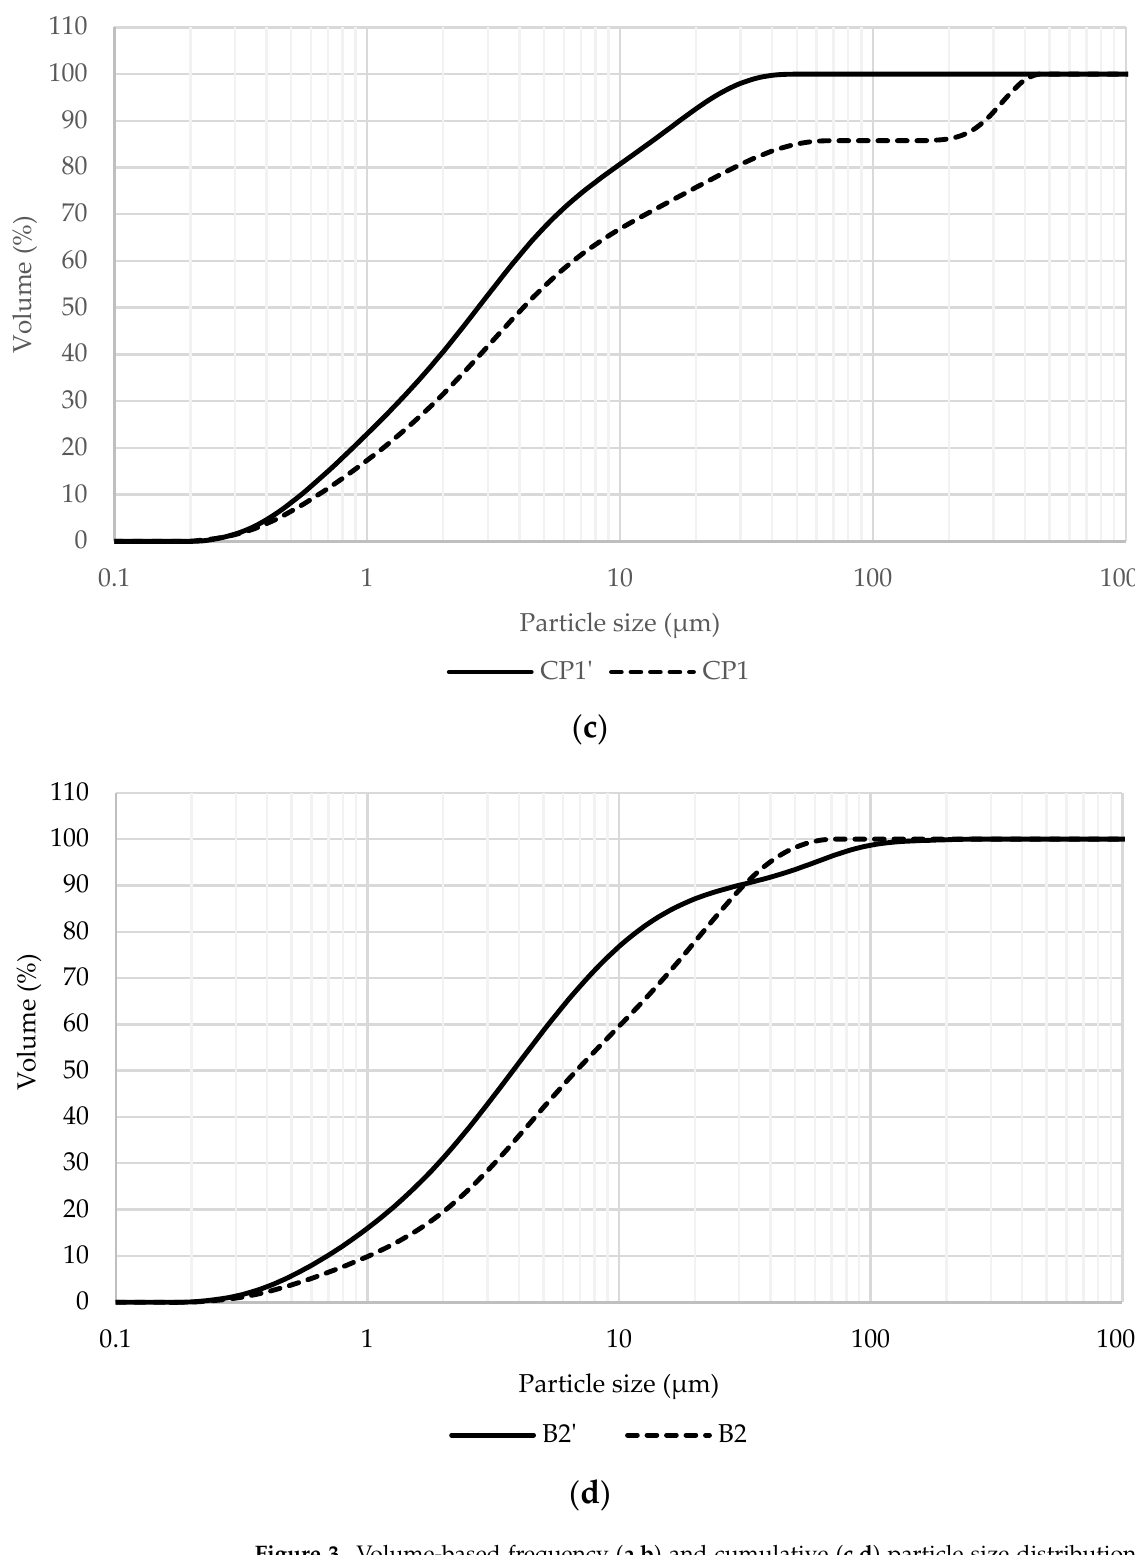
Figure 3. Volume-based frequency ( a , b ) and cumulative ( c , d ) particle size distribution curves of ceramic and biomass ash powders.